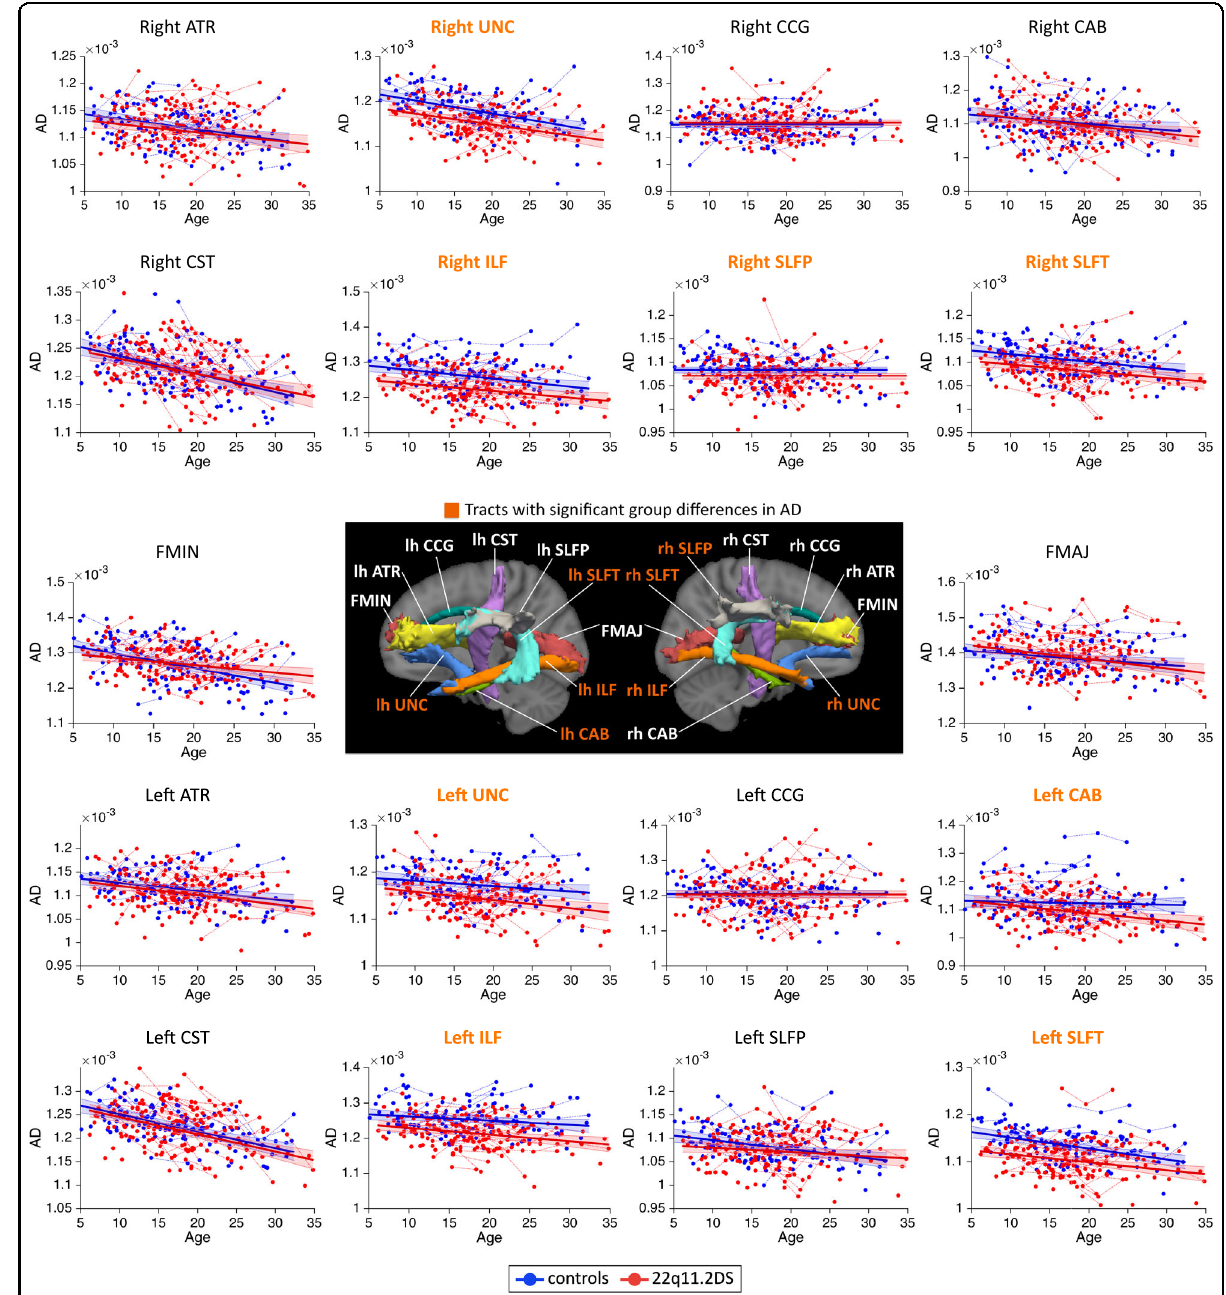
Fig. 2 Developmental trajectories of axial diffusivity (AD) in patients with 22q11.2DS and controls. AD metrics followed linear decreasing trajectories in 22q11.2DS (red) and controls (blue) in most white matter tracts. Age × group interactions were not signi fi cant, indicating that both groups followed parallel developmental curves with similar shapes. Multiple white matter tracts showed signi fi cant group differences in AD, with systematic reductions in 22q11.2DS. Tracts with signi fi cant group differences are highlighted in orange in plot titles and in the central fi gure. The signi fi cance threshold was set at p < 0.05. All results were corrected for multiple comparisons using the FDR method. lh left hemisphere, rh right hemisphere, FMAJ forceps major, FMIN forceps minor, ATR anterior thalamic radiation, CAB cingulum – angular bundle, CCG cingulum – cingulate bundle, CST corticospinal tract, ILF inferior longitudinal fasciculus, SLFP superior longitudinal fasciculus – parietal bundle, SLFT superior longitudinal fasciculus – temporal bundle, UNC uncinate